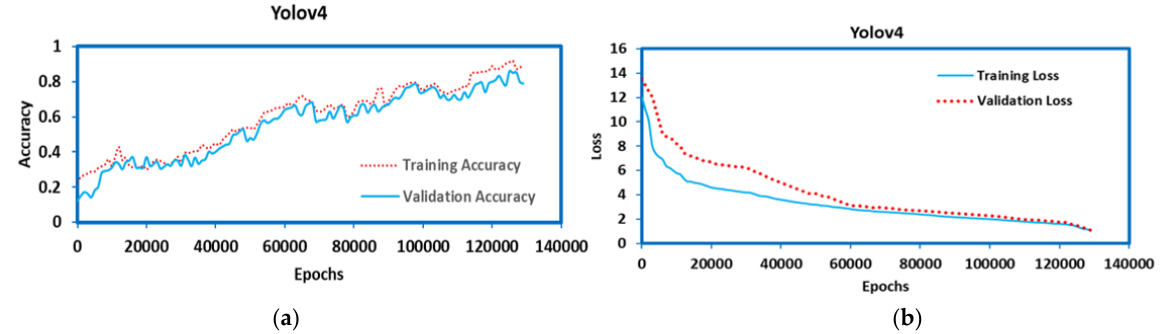
Figure 6. Training and validation process of modified YOLOv4. ( a ) The curve of Accuracy. ( b ) The curve of Loss.